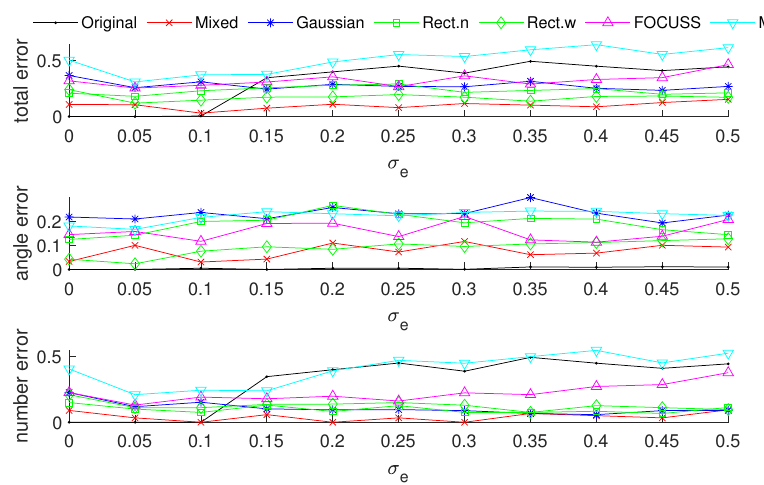
Figure 12. The DOA estimation error in terms of the OSPA distance via different subarrays when the prior distributions are given by N ( 400,50 2 ) and N ( 800,50 2 ) and the true distributions are given by N ( 1200,50 2 ) and N ( 1600,50 2 ) .